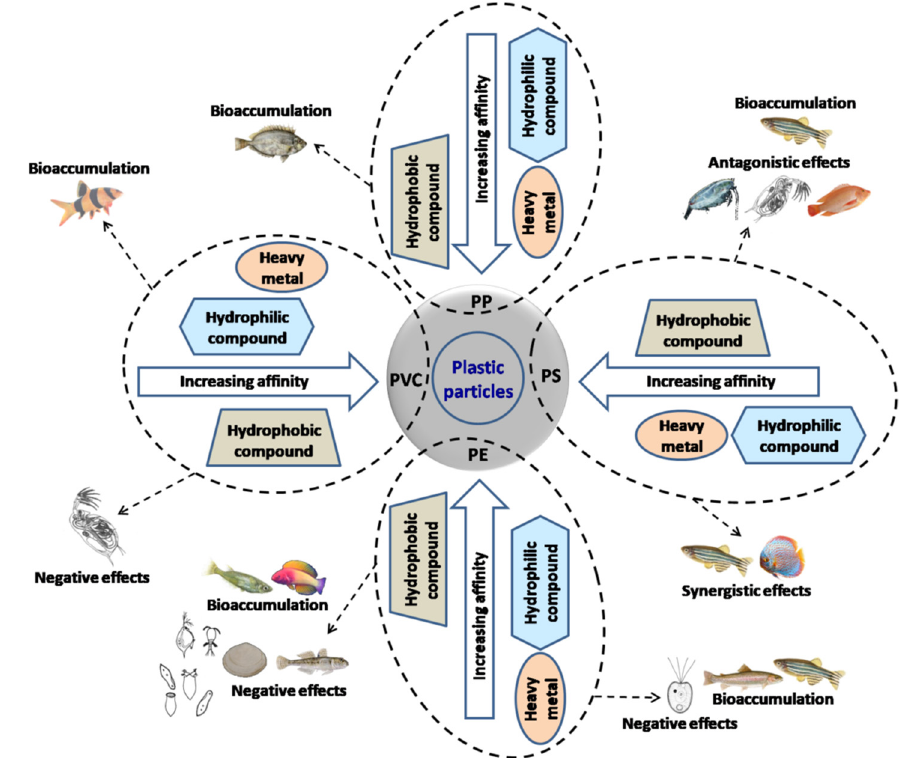
Figure 4. Schematic representation of the affinity between different plastic particles (PP: polypropylene, PE: polyethylene, PS: polystyrene and PVC: polyvinyl chloride) and different contaminants (hydrophilic compounds, hydrophobic compounds and heavy metals) and the impacts of their mixed exposure to aquatic organisms.